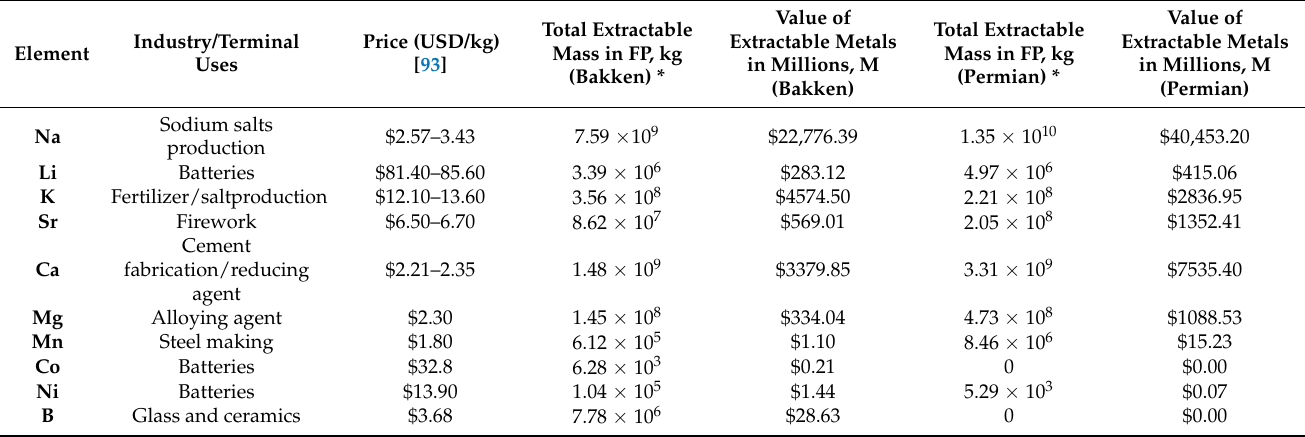
Table 3. Quantities and values of extractable metals from Permian Basin and